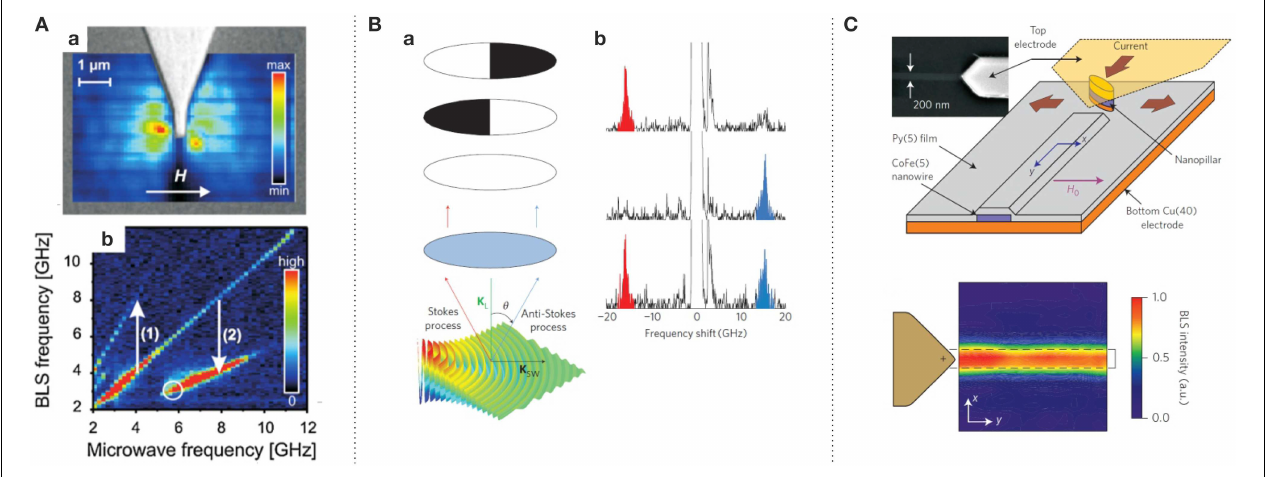
FIGURE 10 | (A) Top: BLS microscope image of the spatial spin-wave profile radiated from a point contact when driven with a microwave current. Bottom: Non-linear spin-wave processes at large excitation powers showing frequency doubling and splitting, taken from Schultheiss et al. [106]. (B) Detection scheme to prove the propagating character of the spin-wave